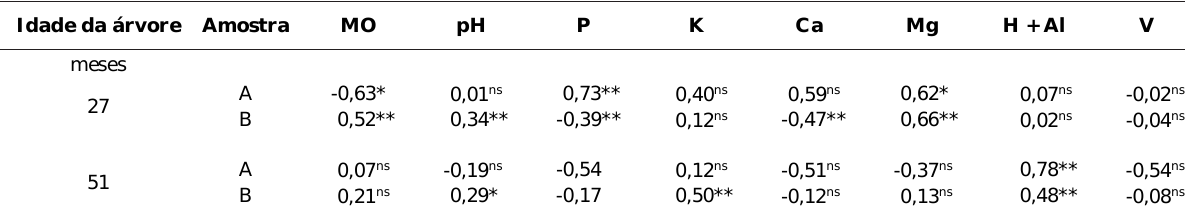
Quadro 3. Coeficientes de correlação entre período de imaturidade (PI) e as determinações na análise